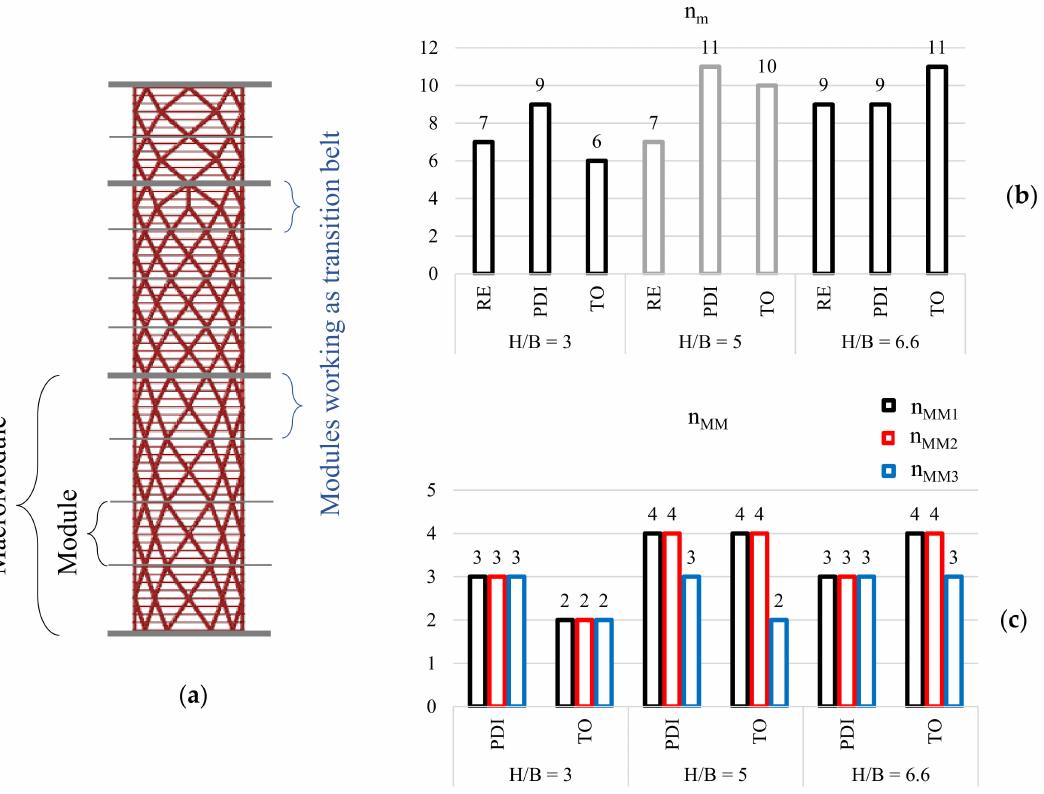
Figure 9. ( a ) Identification of macro-modules, modules and transition belt, ( b ) total number of modules, n m , in the analysed patterns, ( c ) number of modules for each macro-module n mj in the Principal Direction Inspired (PDI) and TO